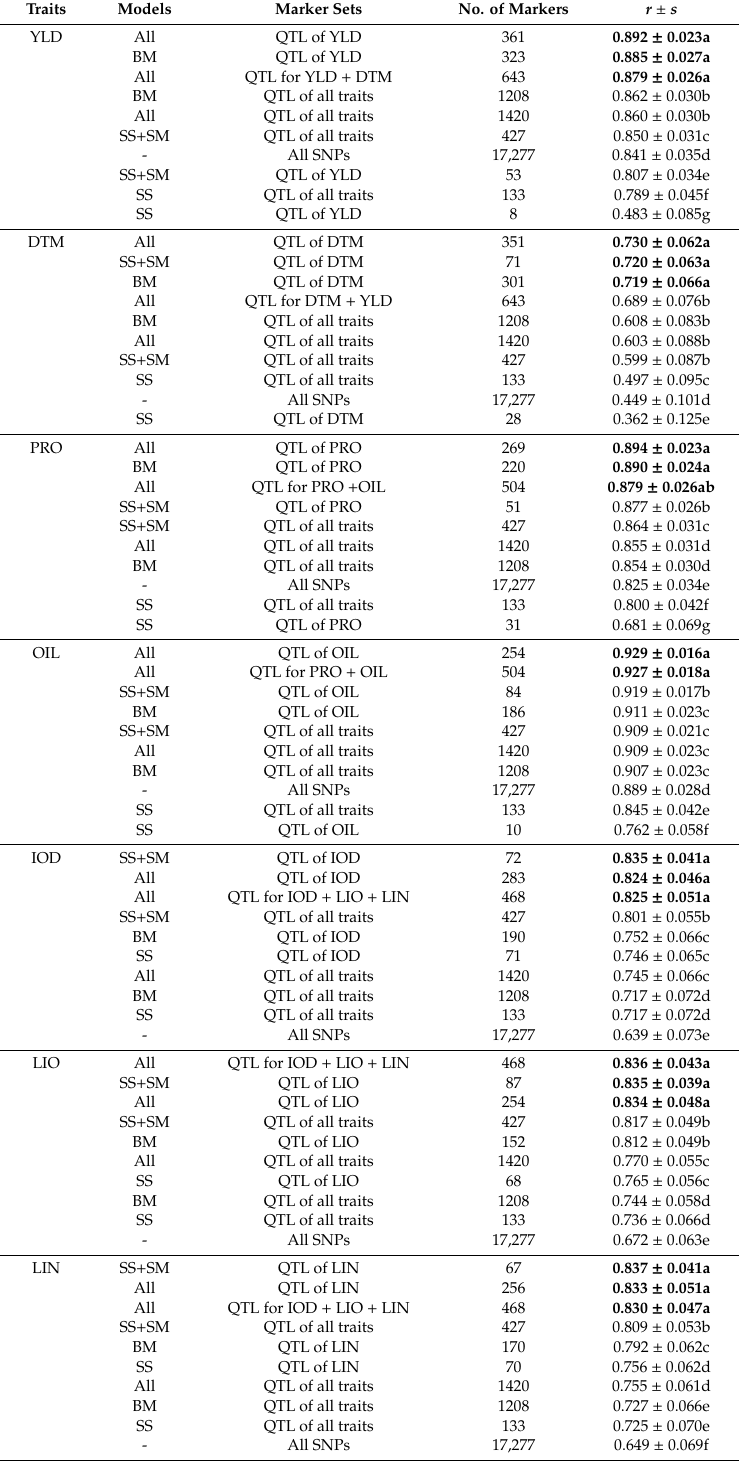
Table 4. Prediction accuracy ( r ± s ) of seven traits using all single nucleotide polymorphisms (SNPs) and di ff erent combinations of quantitative trait loci (QTL) identified by di ff erent combinations of statistical models. GBLUP was used to estimate r